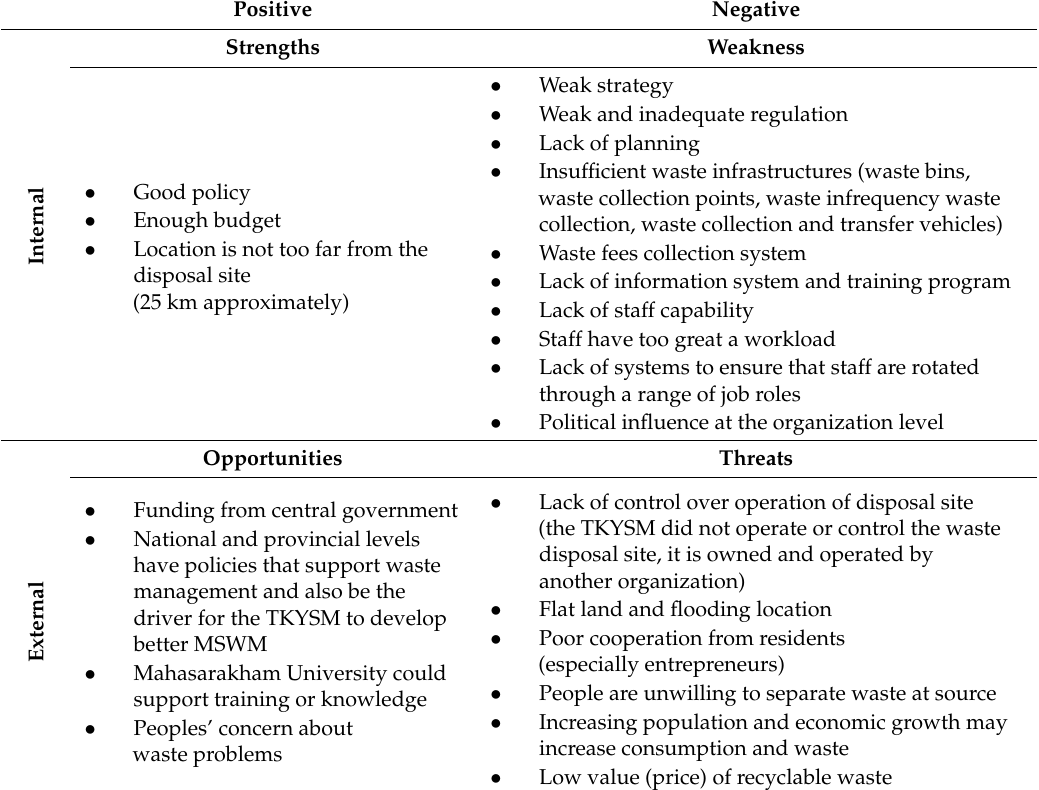
Table 3. SWOT analysis for MSWM in Tha Khon Yang Subdistrict